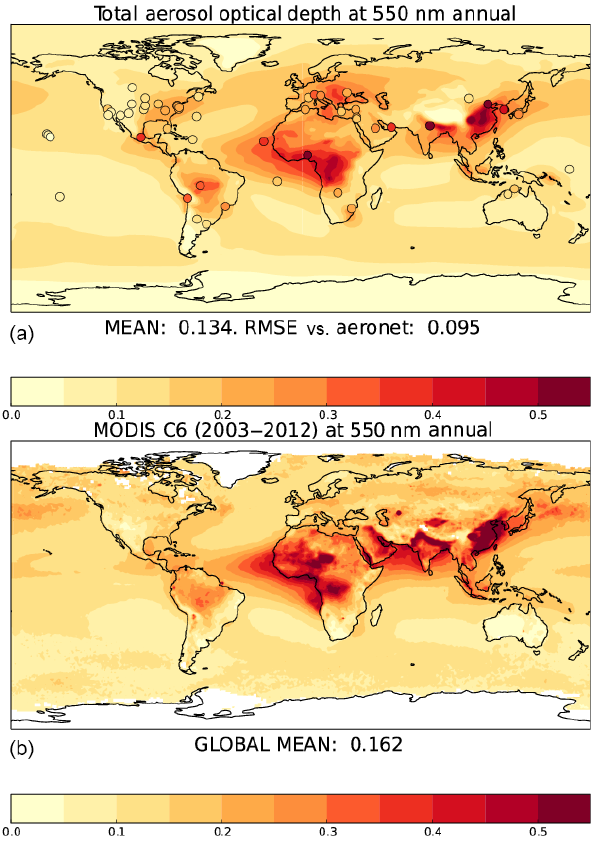
Figure 7. Annual mean AOD at 550nm from a 20-year N96 atmosphere/land-only GA7/GL7 climate simulation (a) and satellite observations from the Moderate Resolution Imaging Spectrometer (MODIS; b ). The annual mean MODIS observations are derived from monthly mean level 3 products from MODIS Aqua Collection 6 (Sayer et al., 2014) and cover the period 2003–2012. An annual mean climatology of level 2 AOD observations at 500nm from the ground-based AERONET sun photometer network (Holben et al., 2001) at 67 worldwide locations are overlaid on the GA7 spatial plot.